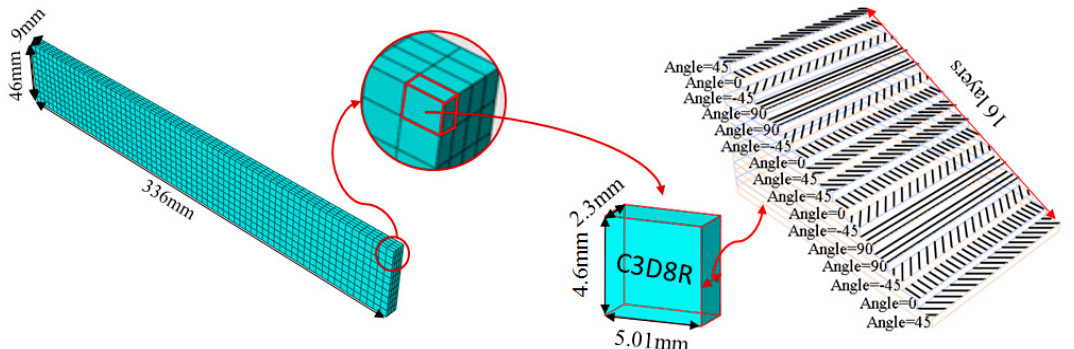
Figure 6. The finite element model of CFRP.